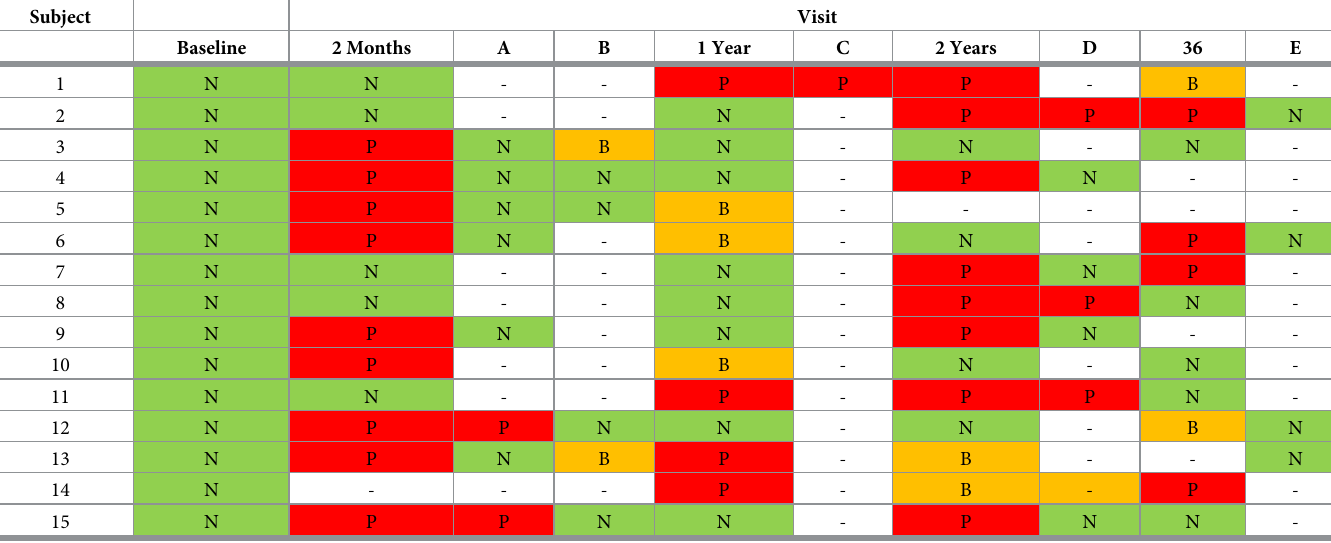
Overall, those studies noted that prevalent positives had stronger assay responses than incident positives, and that among converters weaker assay responses were more commonly associated with reversion. There were fewer cases of incident TB disease among the reverters, but with the limited numbers the difference was not statistically significant. In our study using the